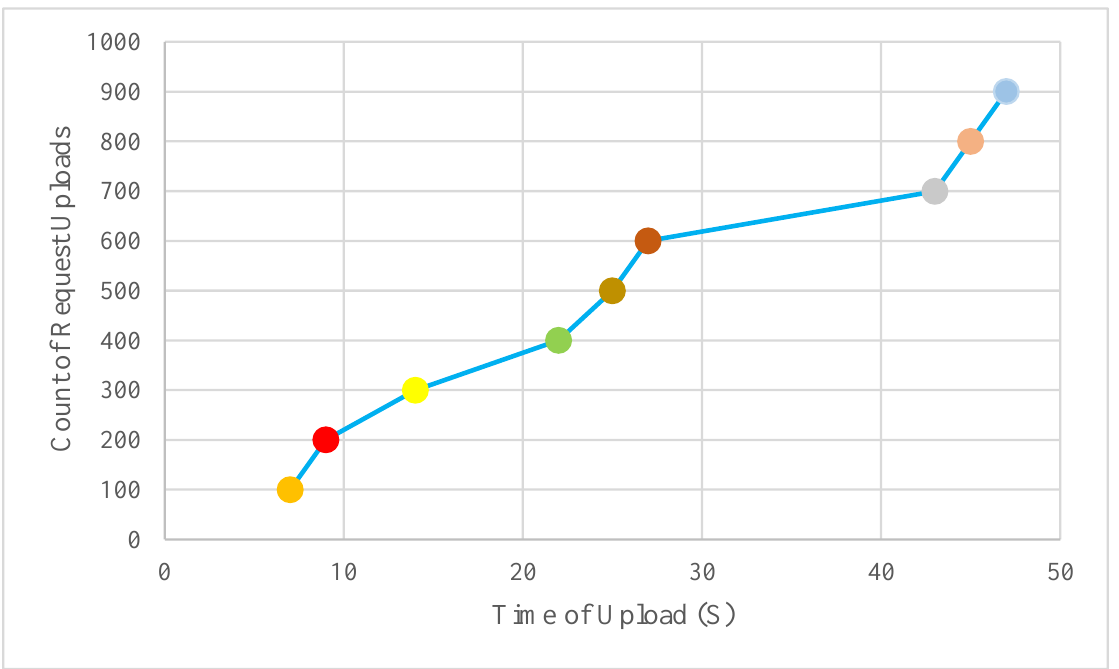
Figure 8. Relationship between the uploaded request and uploaded